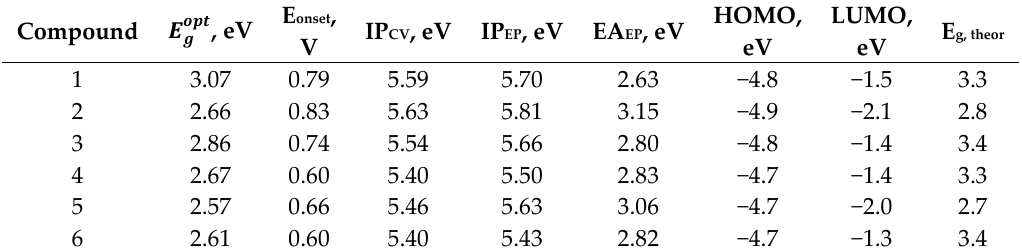
The onset oxidation potentials (E onset ) versus Fc measured by CV from the first redox cycle. The optical band gap ( 𝐸 (cid:3034)(cid:3042)(cid:3043)(cid:3047) ) estimated from the edges of absorption spectra of solid samples (E gopt = 1240/ λ onset. ). Ionization potentials (IP EP ) measured by photoelectron emission in air method. Ionization potentials (IP CV ) measured by CV: IP CV =4.8+E onset [31]. Electron affinities calculated using equation EA EP = IP EP ‐ 𝐸 (cid:3034)(cid:3042)(cid:3043)(cid:3047) . HOMO/LUMO ‐ energies of highest occupied and lowest unoccupied molecular orbitals. E g, theor